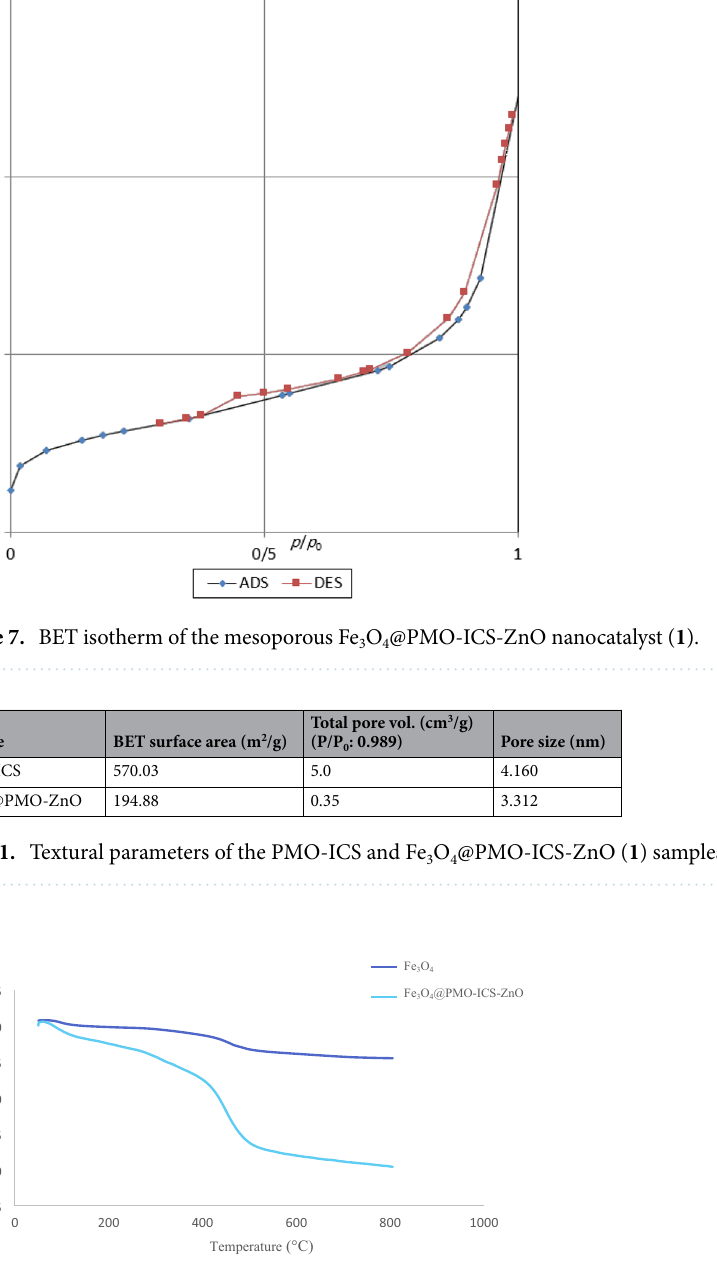
Figure 8. TGA curve of the Fe 3 O 4 @PMO-ICS-ZnO catalyst ( 1